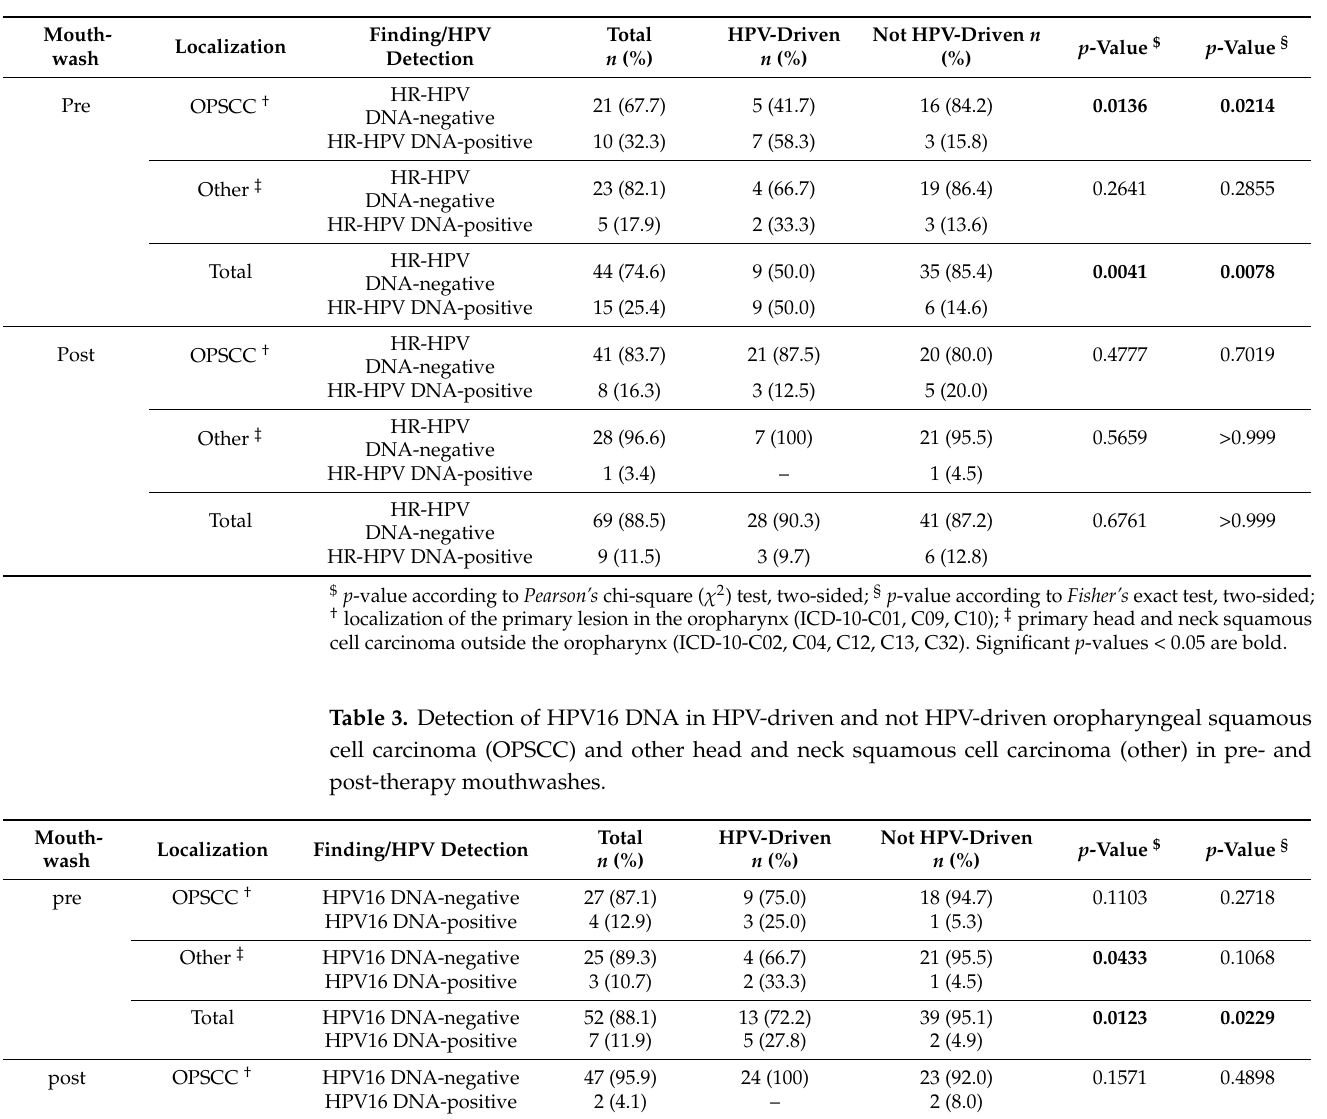
Table 2. Detection of HR-HPV DNA in HPV-driven and not HPV-driven oropharyngeal squamous cell carcinoma (OPSCC) and other head and neck squamous cell carcinomas (other) in pre- and post-therapy mouthwashes.